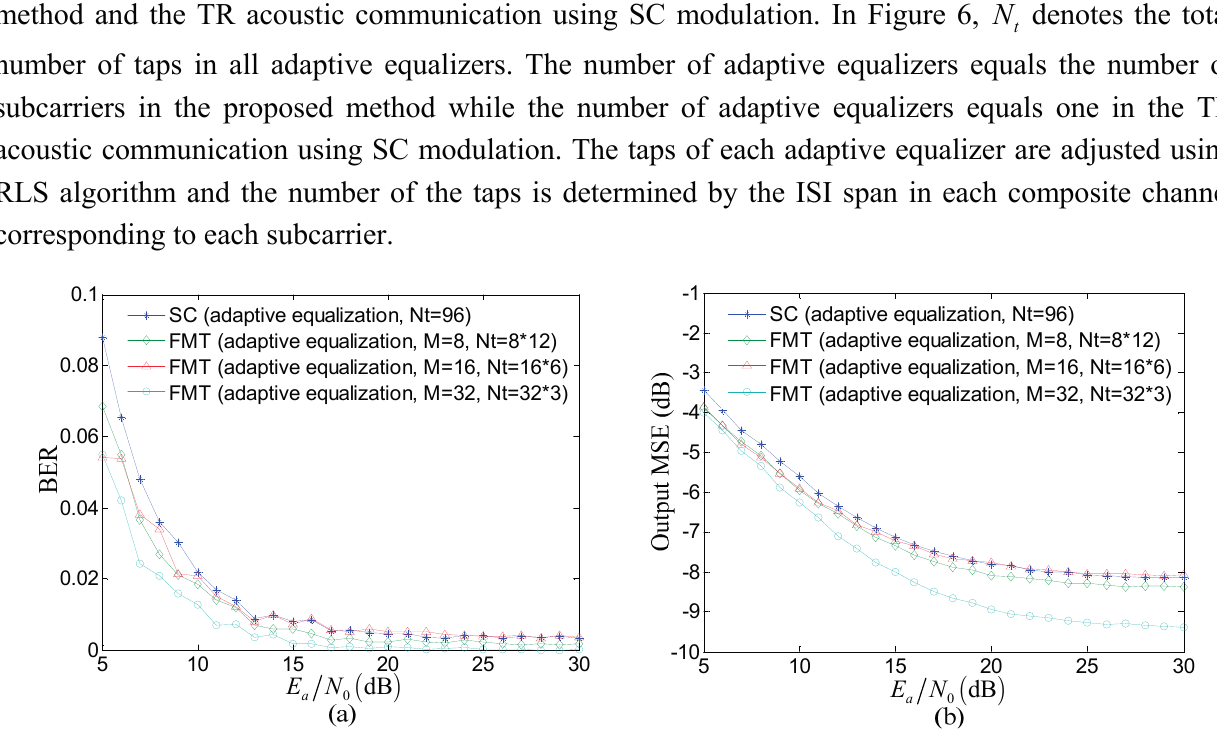
Figure 6. Comparison of the performance of adaptive equalization for post-process between the proposed method and the TR acoustic communication using SC modulation: ( a ) BER; and ( b ) output